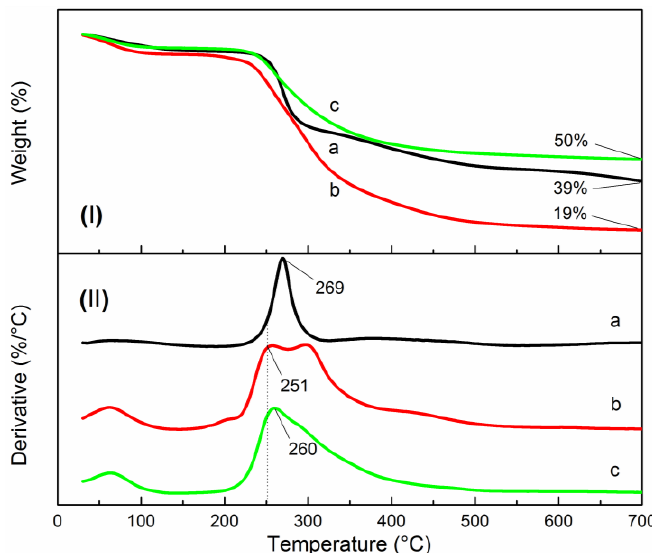
Figure 10. Thermogravimetric (TG) curves of ( a ) CMC, ( b ) QCMC and ( c ) QCMC-Ag, ( I ): thermogravimetric analysis (TGA) curves; ( II ): derivative thermogravimetry (DTG) curves.